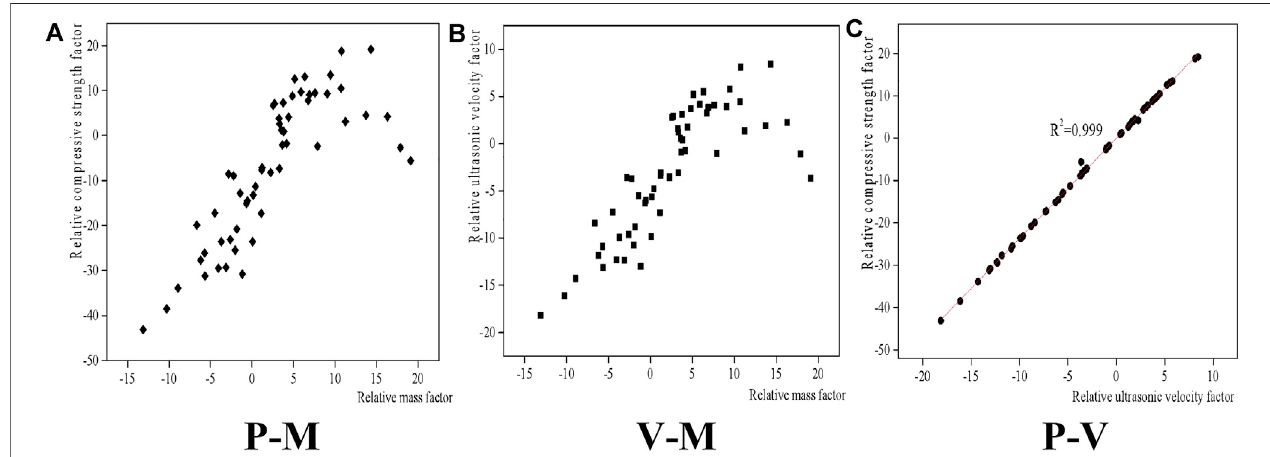
FIGURE 3 | Corresponding relationship of three corrosion factors.